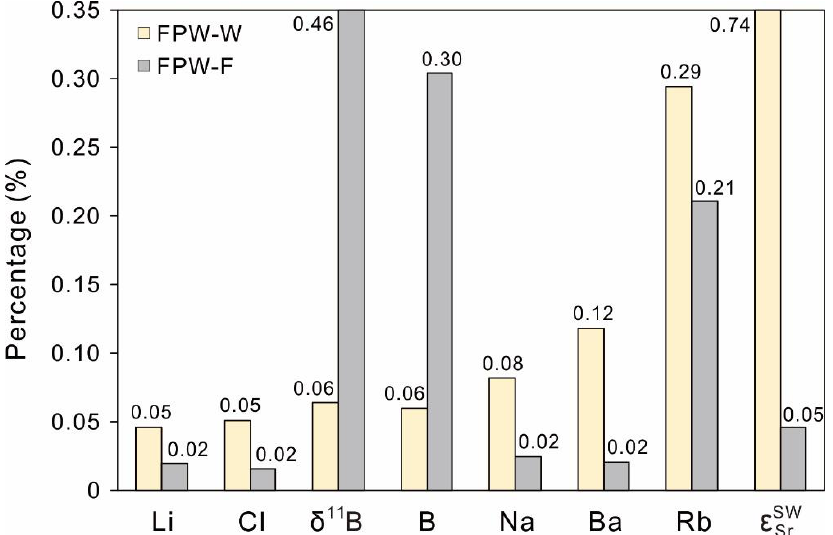
Figure 10. The sensitive monitoring indicators (ions and isotopes) for identifying either FPW-W or FPW-F mingling with shallow groundwater in Xishui. The percentages are the threshold values of FPW mixed with the shallow groundwater, causing statistical changes of specific indicators (| Δ |) that are equal to the natural variation of shallow groundwater (3 σ ).